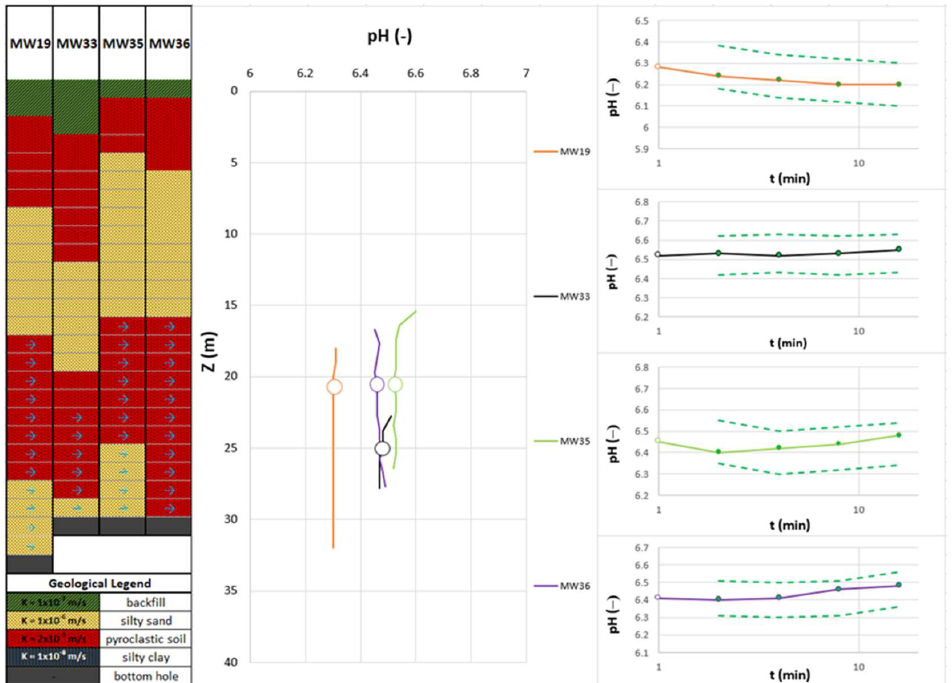
Figure 10. Layout of coupled log-purging (z-t) pH results for low-heterogeneity well types (MW19, MW33, MW35 and MW36).